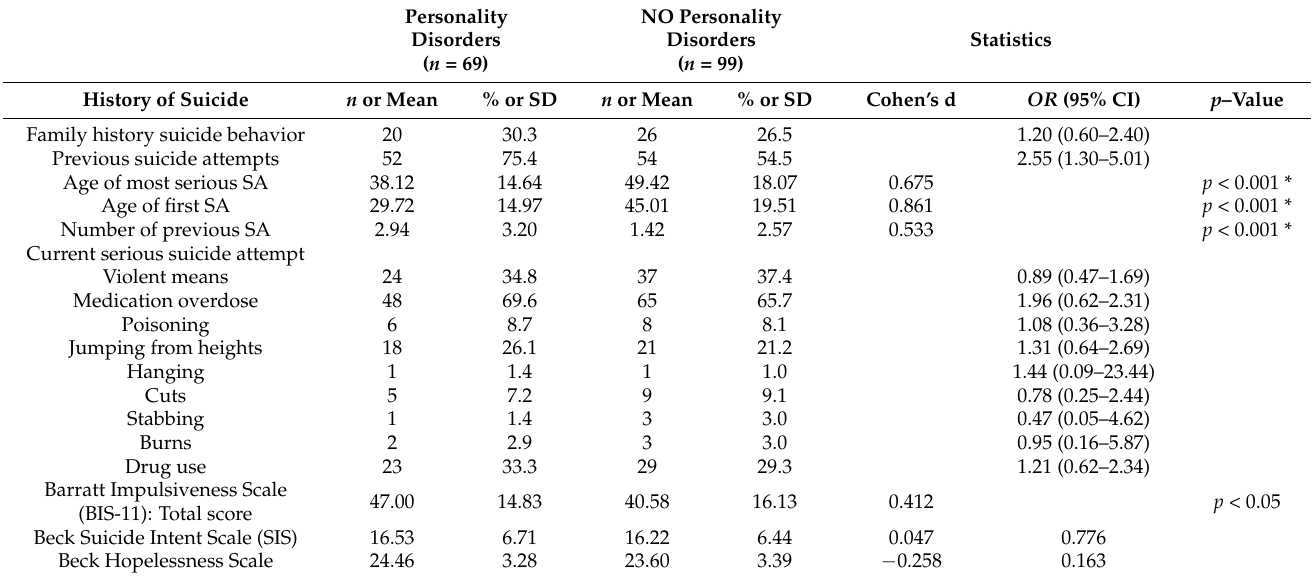
Table 2. Differences in past and current suicide behavior between groups and in Impulsivity, Hopelessness and Suicide Intent